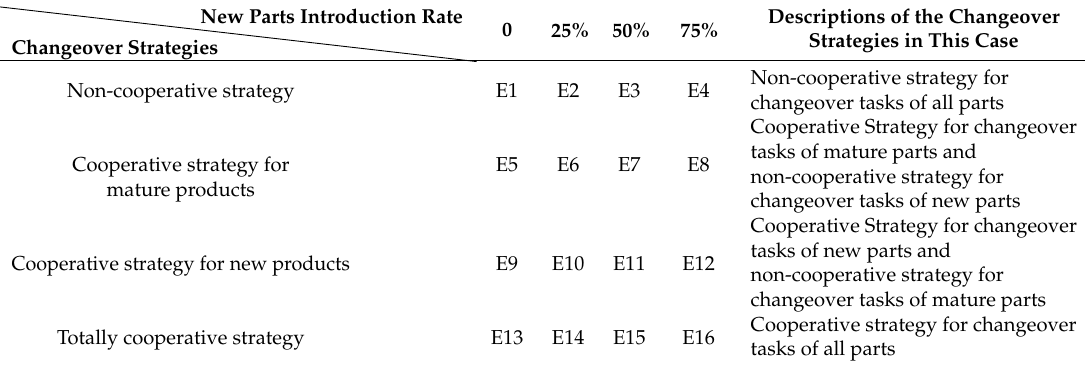
Table 5. Experimental